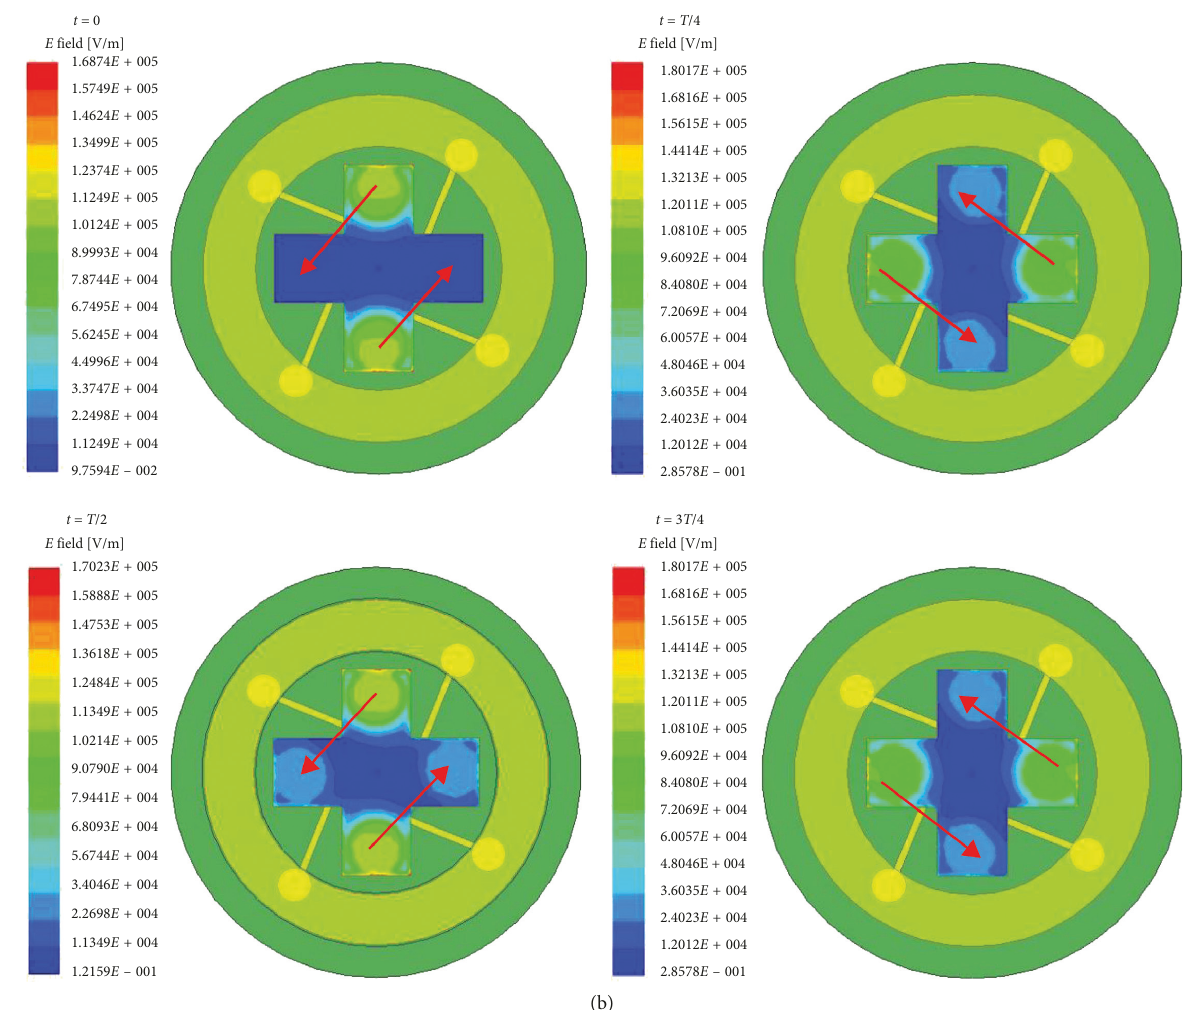
Figure 5: Electric field distributions of the antenna at (a) 1.225GHz (L2) and (b) 1.582GHz (L1).